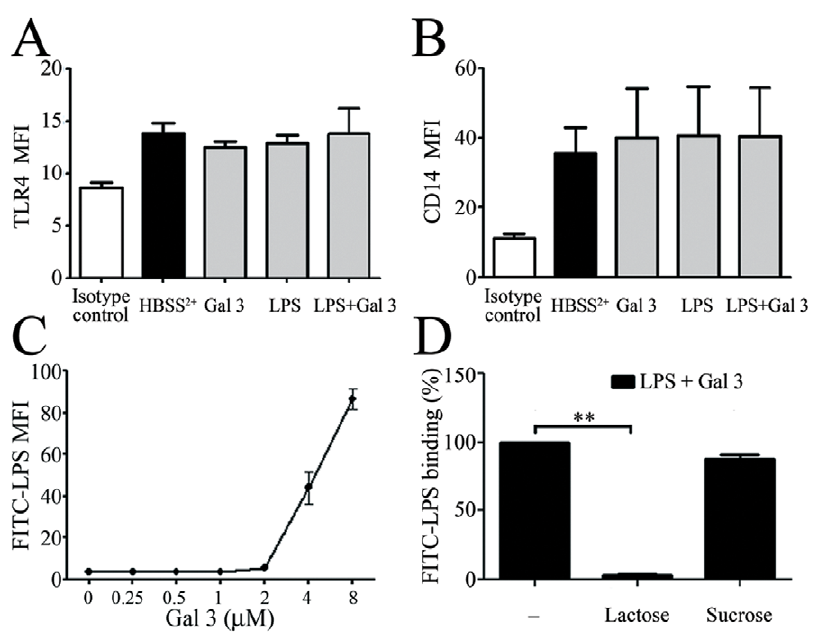
Figure 4. Gal 3 enhances LPS binding to the neutrophil surface. A and B : PMNs (2 6 10 6 /mL) were stimulated for 45 min with Gal 3 (0.4 m M) and E. coli LPS (1 m g/ml), preincubated as in figure 3. TLR4 ( A ) and CD14 ( B ) expressions were determined by flow cytometry. The results are expressed as mean fluorescence intensity (MFI) (n=3). C : FITC-labeled E. coli LPS (12.5 m g/mL) was preincubated with increasing molar concentrations of Gal 3 (from 0.25 to 8 m M) and then added to PMNs (10 6 10 6 /mL) for additional 20 min incubation at 37 u C with (n=3) D . Gal 3 was treated with 12.5 mM lactose or sucrose for 15 min before being incubated with FITC-LPS (12.5 m g/mL) and added to PMNs (10 6 10 6 /mL). The binding of FITC-LPS was determined by flow cytometry and expressed as mean fluorescence intensity